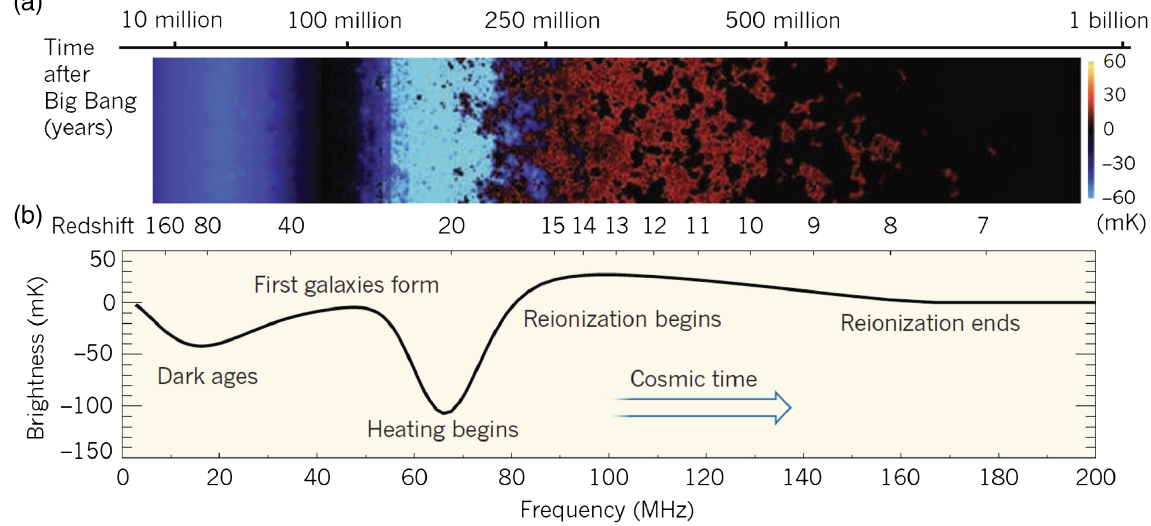
FIG. 30. The evolutionary timeline of the Universe. Image credit: Pritchard and Loeb